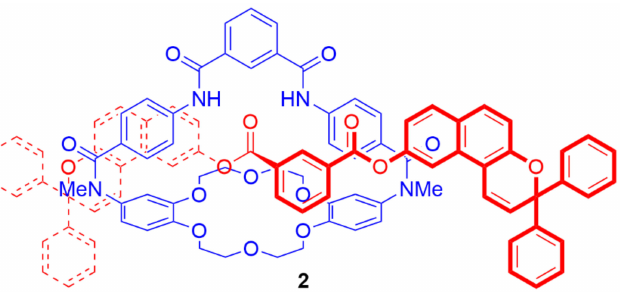
Figure 3. Structure of Moustrou’s rotaxane 2 with chromene stoppers in their closed form.